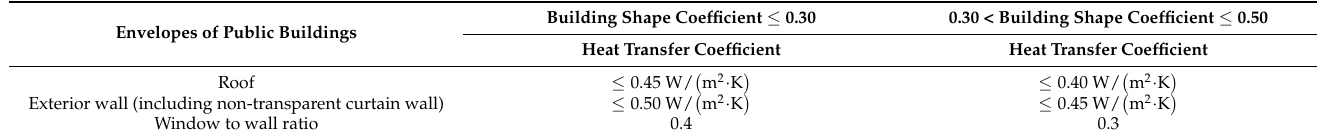
Figure 2. Schematic diagram of laying pipes and floor structure. ( a ) Layout form of floor laying pipe. ( b ) Floor structure and materials. Table 3. Thermal performance limit of a public building’s envelope in cold areas [41].